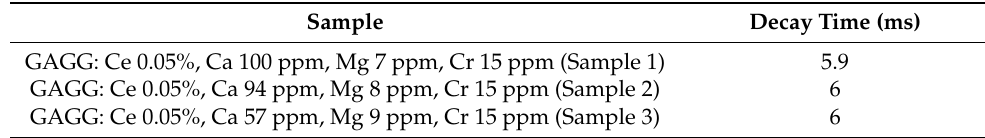
Table 2. Synthesized powder